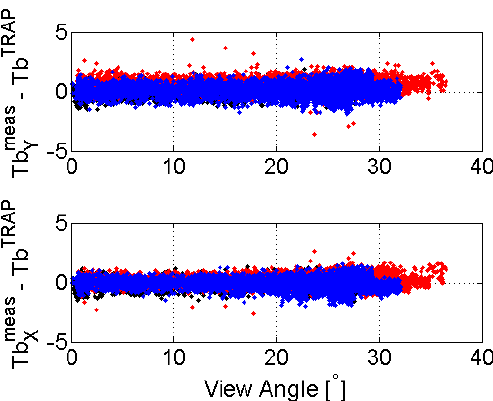
Figure 12. Comparison between measured and simulated antenna temperatures (in K)—for the Y (top) and X (bottom) polarizations, with the nadir antenna—as a function of view angle during the wing wag movements, for the three different flights (black: the first flight, red: the second flight, blue: the third flight) over the ocean during the CAROLS’2009 campaign.